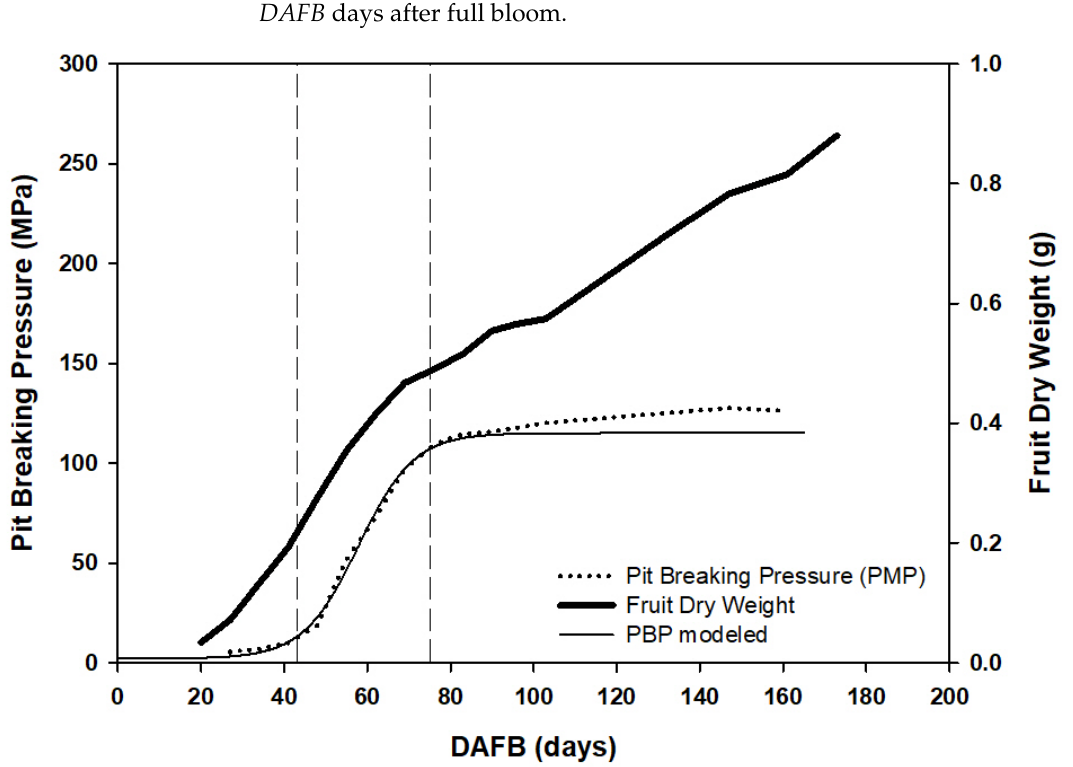
Figure 6. Scheme of seasonal pattern of fruit dry weight (bold line) and endocarp hardening (dotted line). Endocarp hardening was modeled by the equation PBP = (a/1 + e − b(DAFB − c)) + d (solid line). Vertical lines define the three periods considering, according to the velocity of the hardening process.